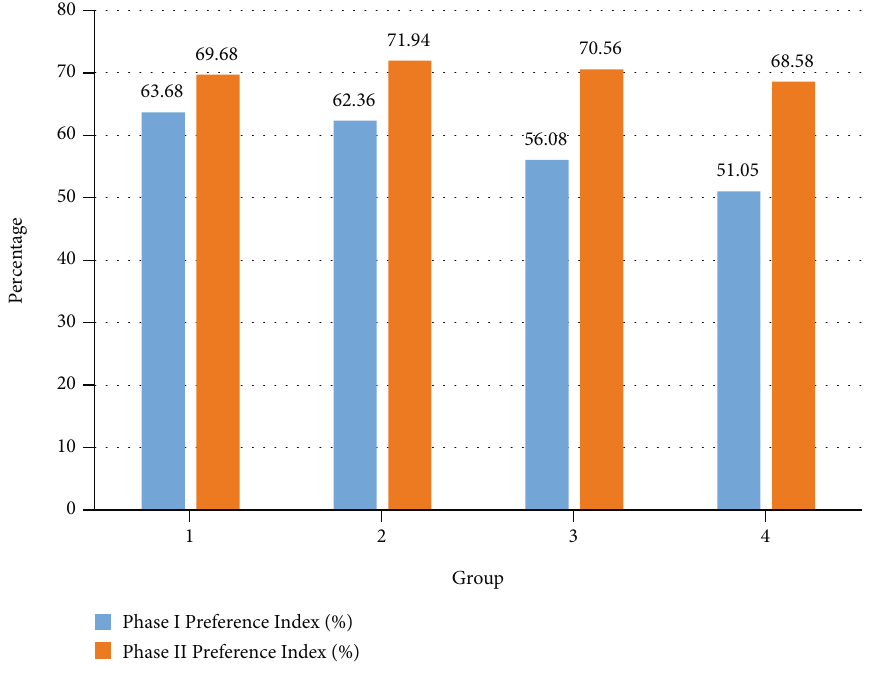
Figure 2: New object recognition experiment results. Table 3: After administration TchE activity in all groups.